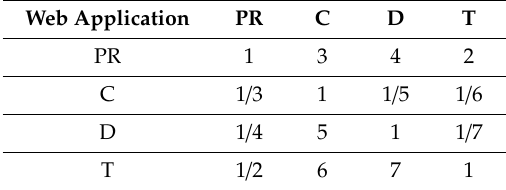
Table 6. The pairwise comparison matrix for the network attributes for web applications.